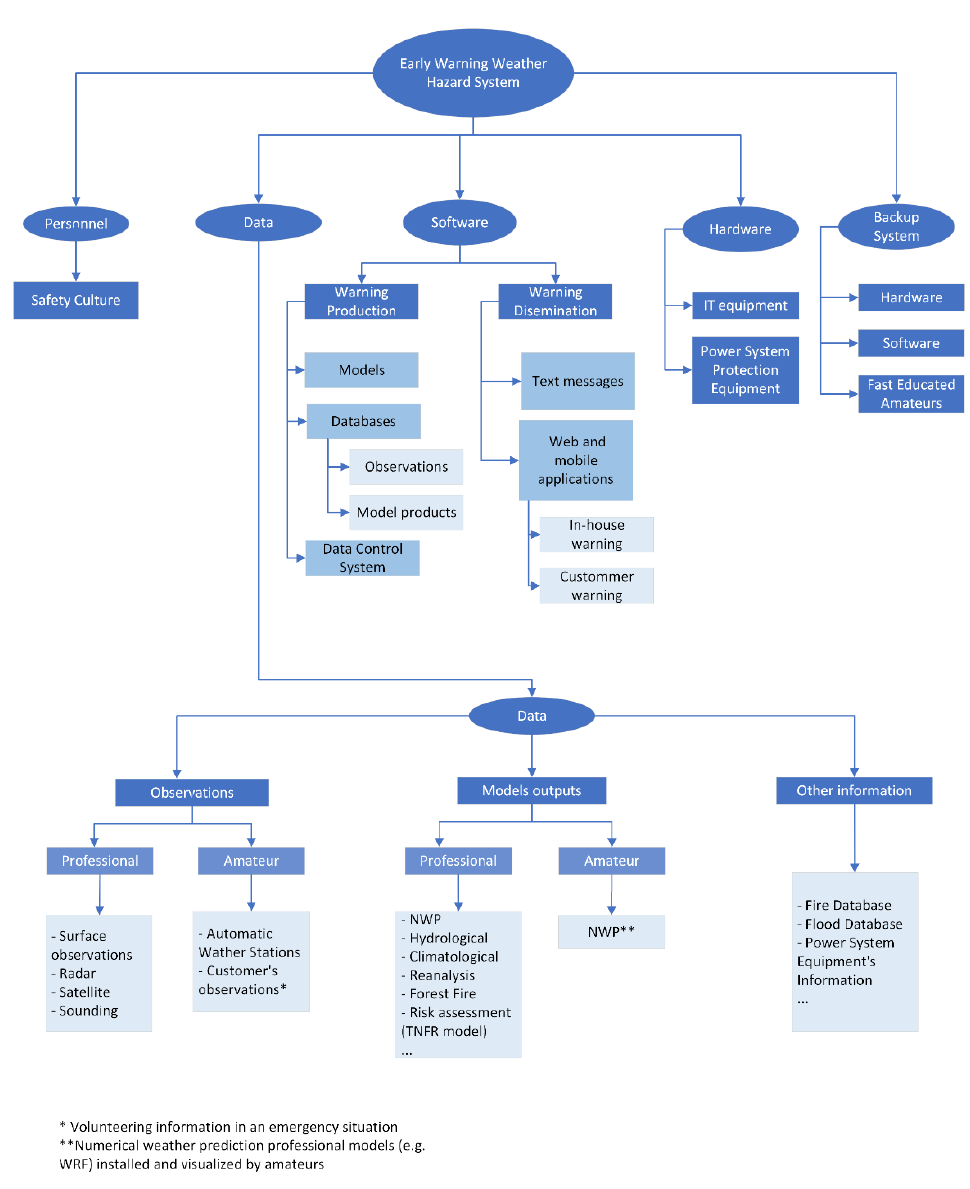
Figure 4. Early warning weather hazard system scheme.